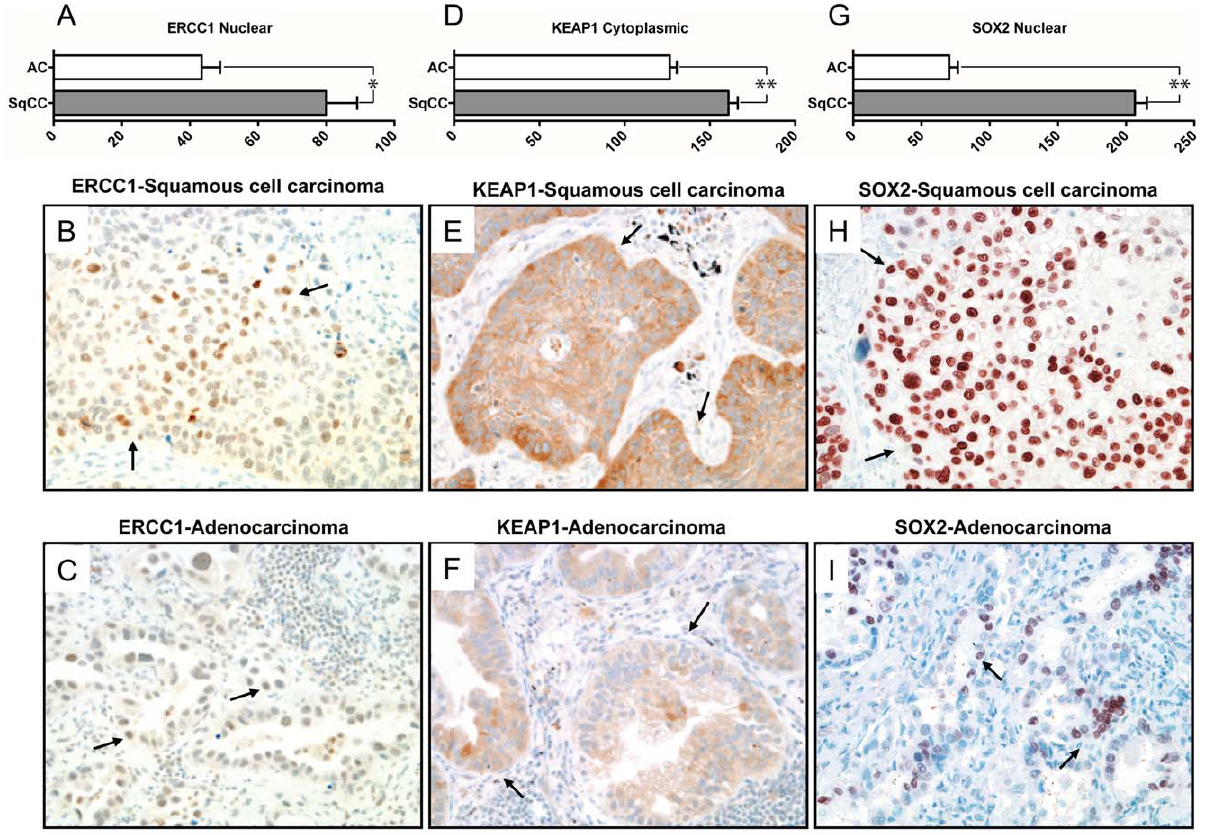
Figure 7. Subtype-specific genomic differences are reflected at the protein level. Immunohistochemical analysis of protein levels for ERCC1 (A–C), KEAP1 (D–F) and SOX2 (G–I) in squamous and adenocarcinoma lung tumors. Average immunohistochemical protein expression levels for each subtype are plotted 6 SEM of each group. Representative microphotograps showing tumoral cells (arrows) with higher levels of immunohistochemistry expression of nuclear ERCC1 ( B and C ), cytoplasmic KEAP1 ( E and F ) and nuclear SOX2 ( H and I ) in squamous cell carcinomas ( B, E and H ) compared to lung adenocarcinomas ( C, F, and I ). Images are of samples reflecting the average protein expression for each group (ERCC1: SqCC = , 80, AC = , 43; KEAP1: SqCC = , 161, AC = , 126; SOX2: SqCC = , 207, AC = , 70). Magnification 200x. * and ** = p , 0.001 and p , 0.0001, two-tailed unpaired t test with Welch’s correction, respectively.